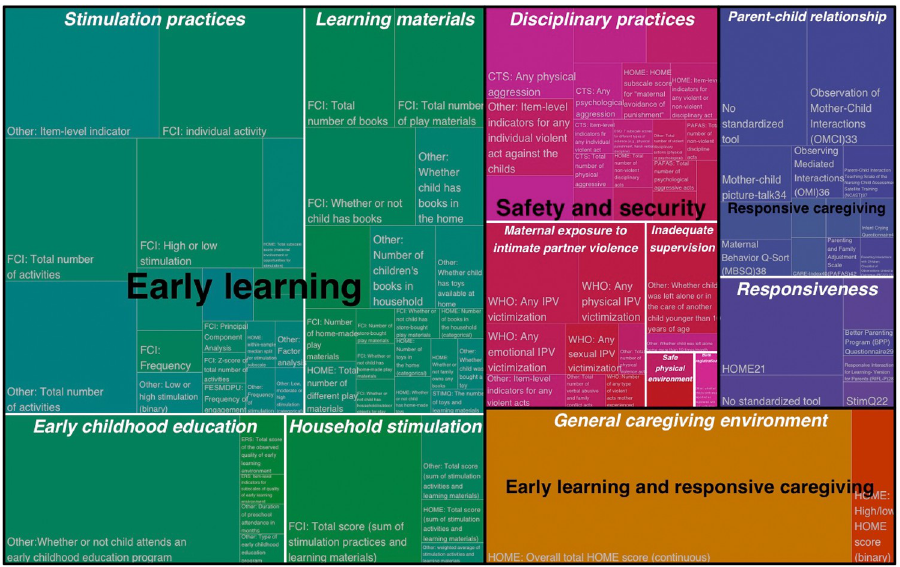
Fig 3. Treemap of constructs and indicators hierarchically organized for early learning, responsive caregiving, and safety and security components of nurturing care. Each rectangle represents a unique indicator that is nested in terms of three levels: nurturing care component (e.g., early learning), construct (e.g., learning materials), and indicator (e.g., numbers of books in the home). The size, location, and color of the rectangle is proportional to number of unique studies and the hierarchical